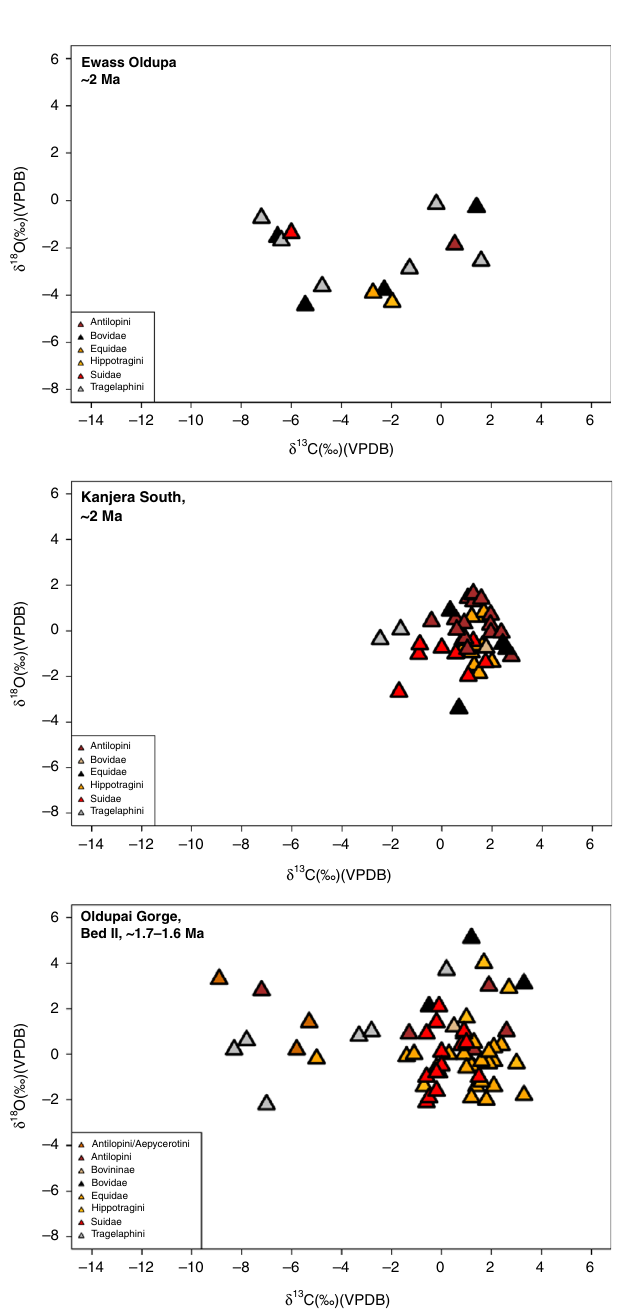
Fig. 8 Stable carbon ( δ 13C) and oxygen ( δ 18O) measurements of animal teeth from Ewass Oldupa (below Tuff IA) compared to contemporaneous and younger fossil datasets 14,75 . A Mann – Whitney – Wilcoxon test shows signi fi cant difference in δ 13C [ W = 215, <0.05(0.004)]. There is also δ 18O distinction: [ W = 92, <0.05(0.000)]. Overall, the results suggest that the period 2.0 – 1.9 Ma was wetter than 1.8 – 1.6 Ma. Note: only data from the same families of taxa have been included in the Isotopic n -alkane (C 29 C 31 C 33 ) values for Upper Bed I from regressive lakeshores and small streams between Tuff IA-IB show open woodland with mixed C 3 – C 4 habitats (Figs. 1 and 7a, d – f) in a stratigraphic position equivalent to that of the oldest Homo habilis in the Eastern basin 30 (OH 24). The succession of Oldowan occupations ends with artefacts from a lakeshore context sandwiched between Tuff IB and IC (1.848/1.832 Ma), in a position and sedimentary environment that on the Western